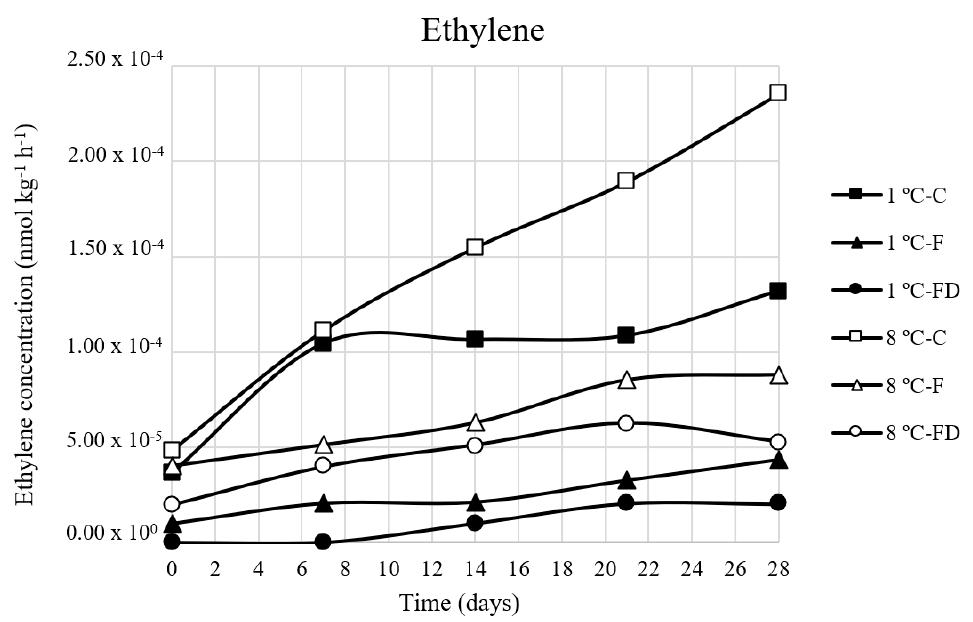
Figure 2. Ethylene concentration expressed as nmol kg − 1 h − 1 over the storage time in pears subjected to the different treatments: 1 °C-C (Control), 1 °C-F (Filter), 1 °C-FD (Filter + Device), 8 °C-C (Control), 8 °C-F (Filter) and 8 °C-FD (Filter + Device).